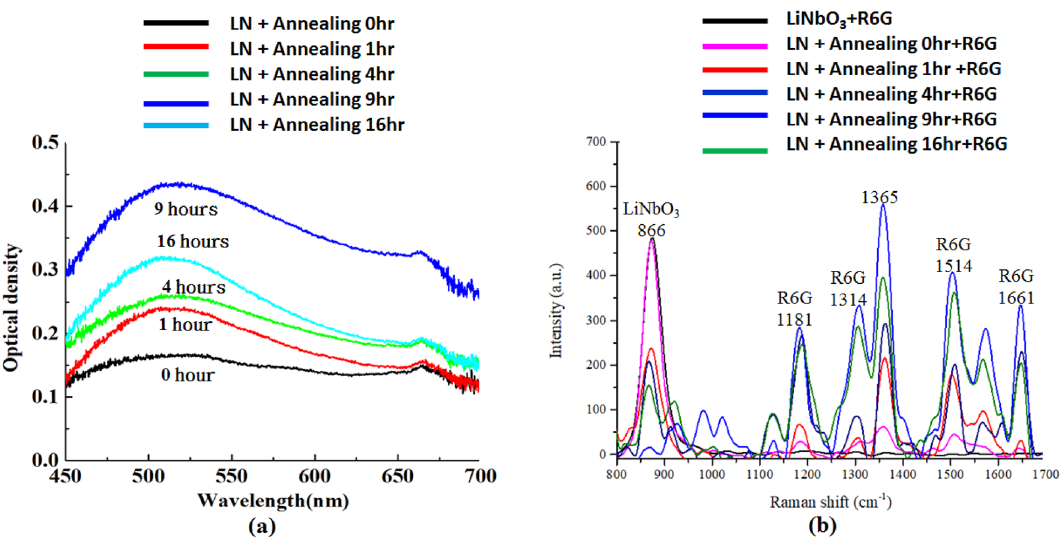
Figure 5. ( a ) Optical density under different annealing times of 0, 1, 4, 9, and 16 h. ( b ) Raman spectra of the rhodamine 6G (R6G) dye on the flat LiNbO 3 and fabricated PPE LiNbO 3 substrates under different annealing times of 0, 1, 4, 9, and 16